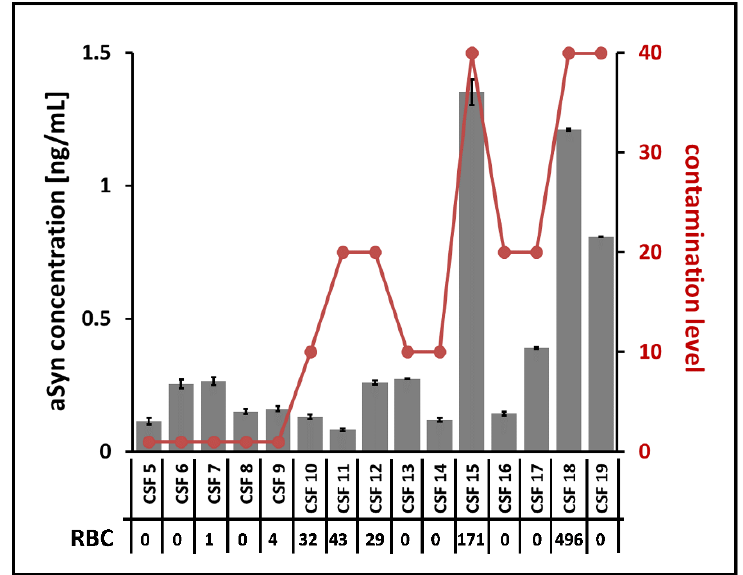
Figure 8. Correlation of ELISA aSyn quantification, contamination levels, and RBC counts from clinical samples. Shown are aSyn concentrations from 15 clinical samples (CSF 5 to CSF 19) obtained by ELISA analysis in relation to the detected contamination levels (marked in red) based on the Combur10-Test ® and to the RBC count from routine laboratory diagnostics. ELISA measurements were performed in duplicate. ASyn was quantified in all samples.